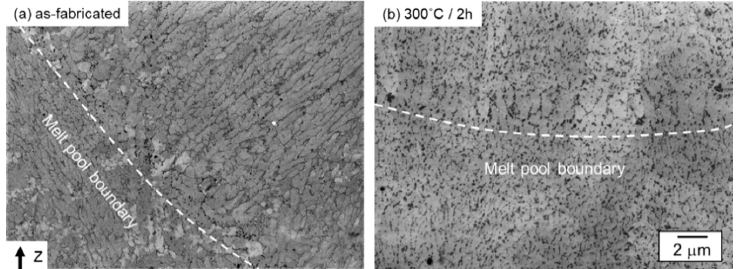
Figure 6. SEM micrographs showing microstructures near the melt pool boundaries of ( a ) as- fabricated and ( b ) 300 °C/2 h annealed samples observed from the sections parallel to the building direction (z axis). ( z